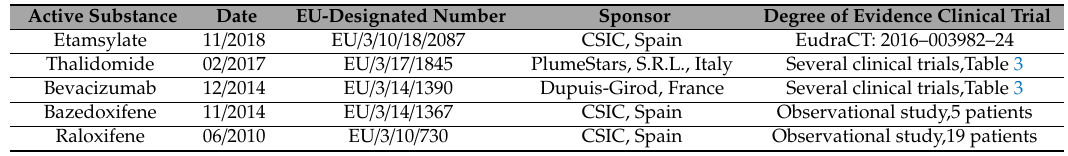
Table 4. Orphan drugs approved by the EMA for